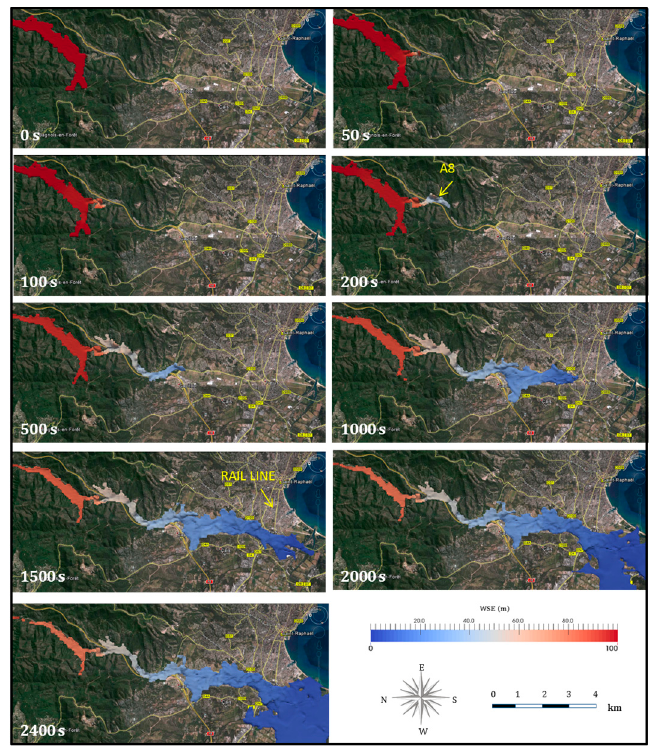
Figure 5. Flooded area at different time steps after dam break.